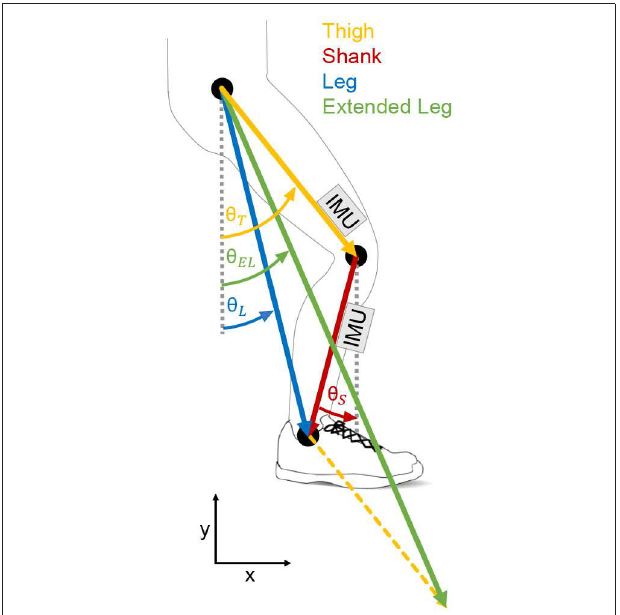
FIGURE 1 | Biological and virtual lower limb segments evaluated for the potential on stance and swing detection. The evaluated biological segments are the thigh (orange) and the shank (red). The evaluated virtual segments (based on Villarreal and Gregg, 2014) are the leg (blue) and the extended leg (green). While the virtual leg is a combination of thigh and shank, the virtual extended leg is a combination of the virtual leg and the thigh. Inertial measurement units (IMU) were place at the thigh and the shank to determine the segment angles and the segment angular velocities.